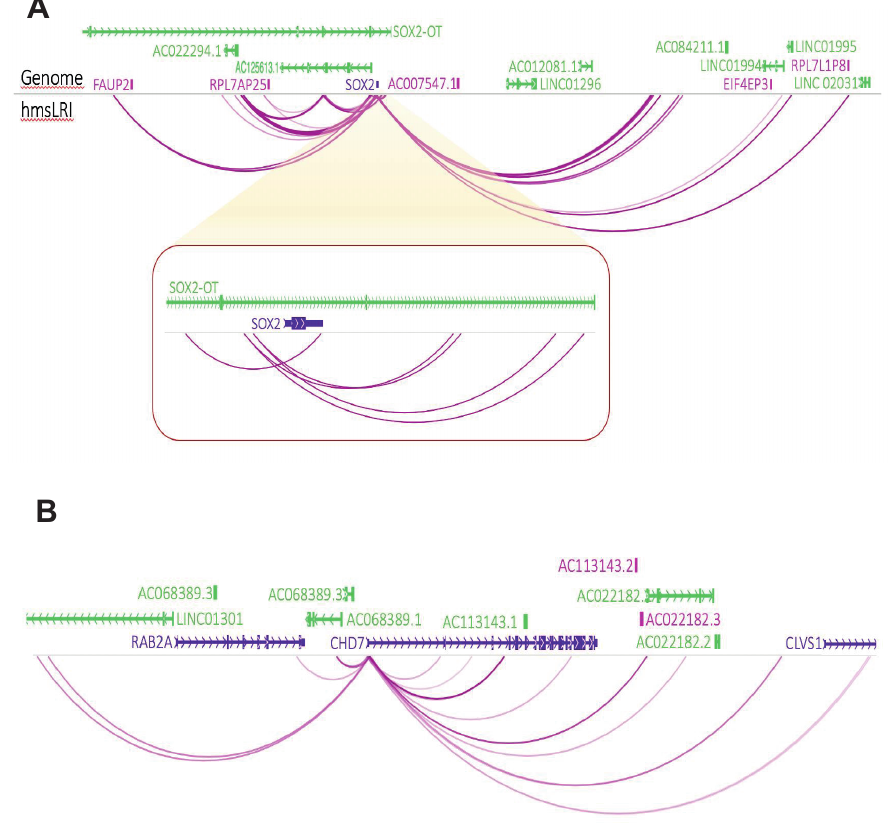
Figure 8. SOX2 and CHD7 promoters show intensive connectivity to distal enhancers . The color intensity of arches is proportional to the number of interactions detected (see PET counts in Table S1). ( A ) SOX2 locus. The red box shows a magnification of the more proximal SOX2 region. ( B ) CHD7